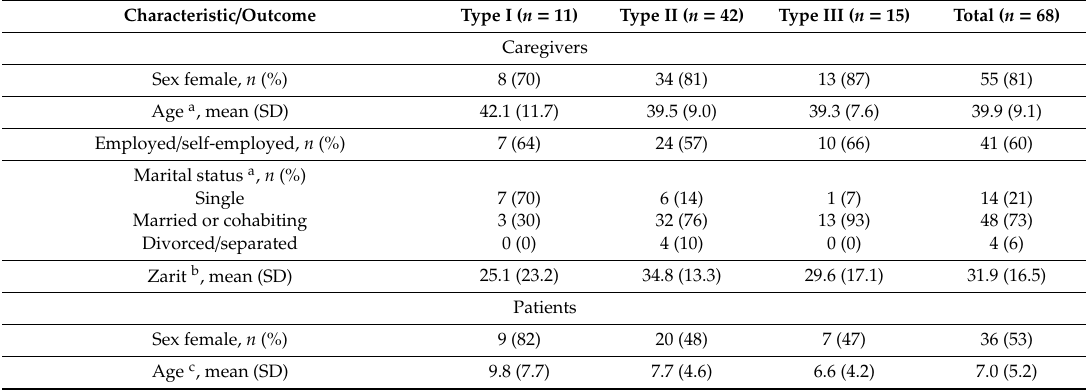
Table 1. Sample characteristics by type of spinal muscular atrophy